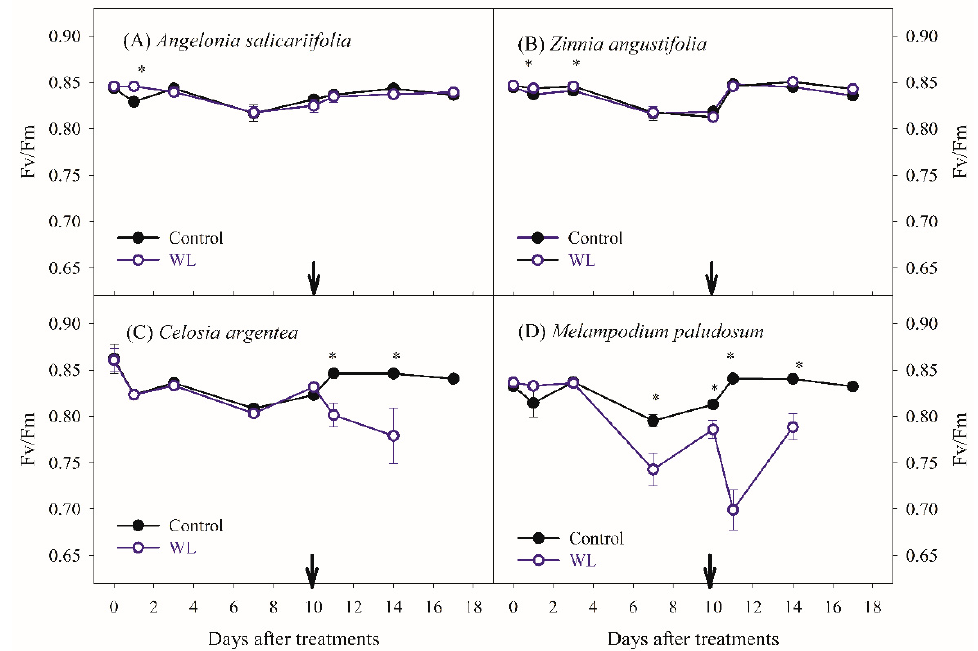
Figure 4. Effects of 10 days of waterlogging followed by a seven-day recovery on maximal quantum yield of photosystem II (Fv/Fm) values of ( A ) Angelonia salicariifolia , ( B ) Zinnia angustifolia , ( C ) Celosia argentea , and ( D ) Melampodium paludosum . Arrows indicate the beginning of the recovery period from waterlogging. * p < 0.05 between the control and waterlogged (WL) plants by a t -test. Both C. argentea and M. paludosum plants had died by day 17. ( n = 5).